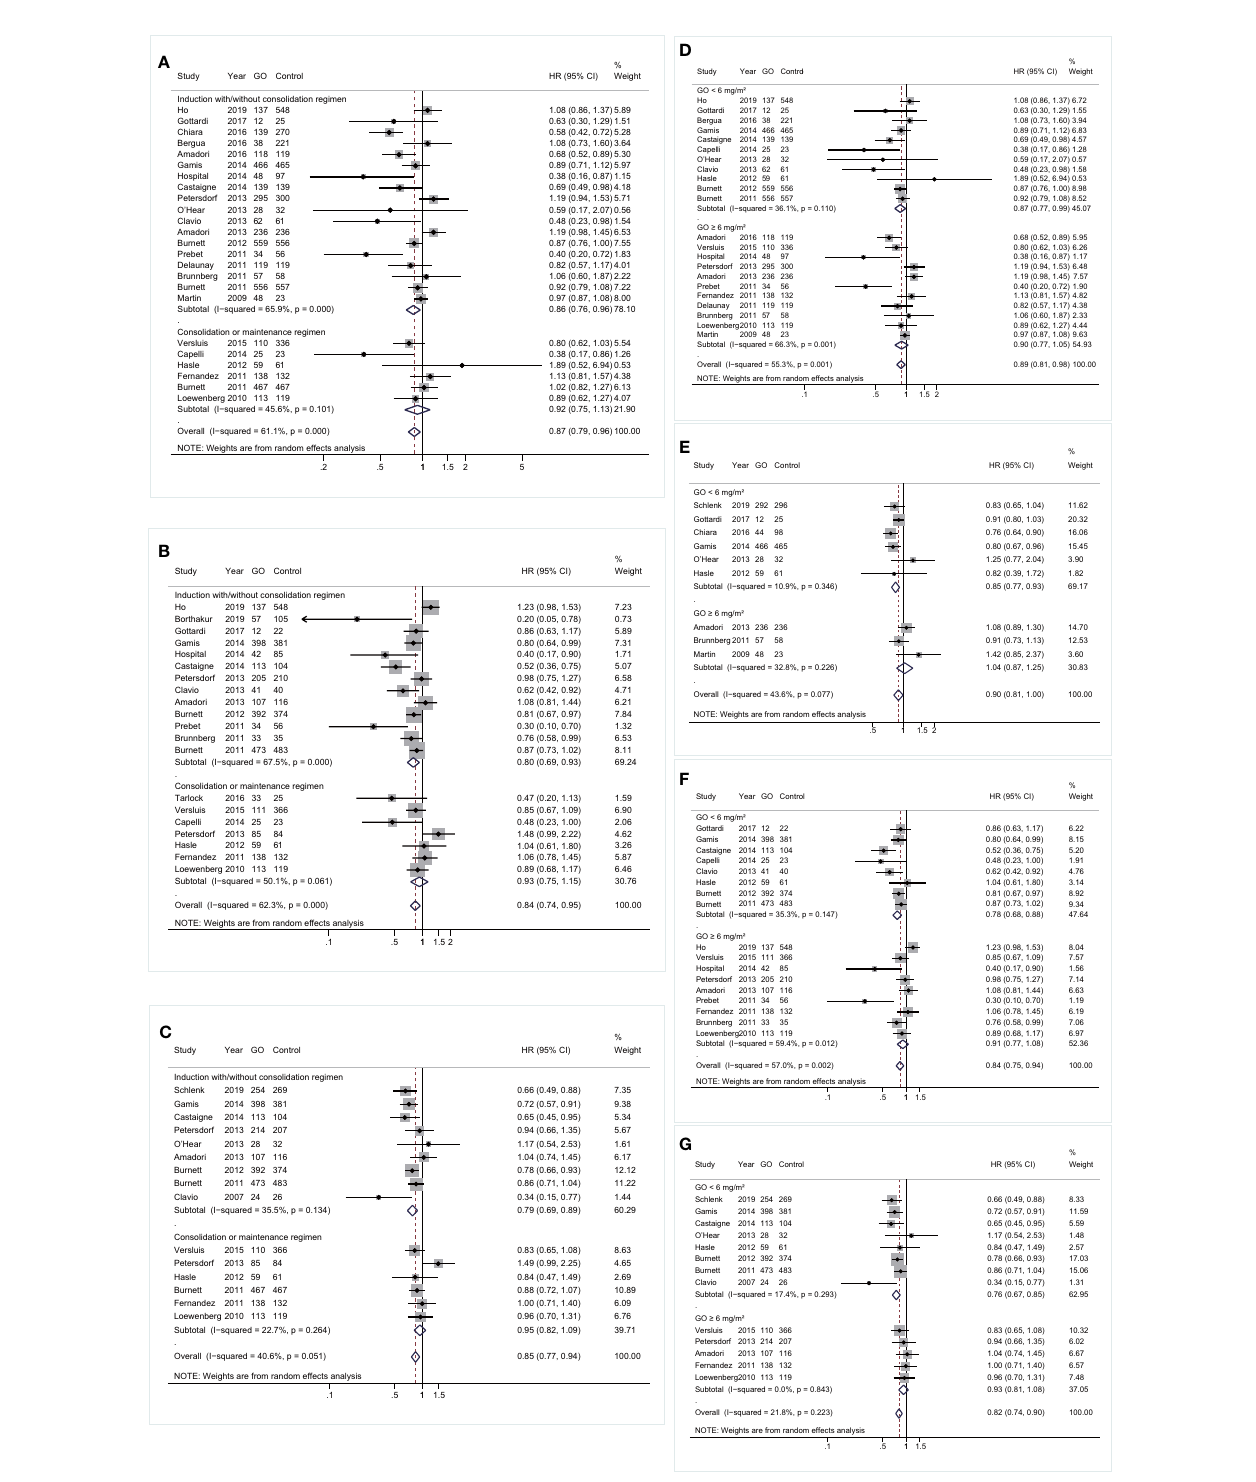
FIGURE 6 | Prognostic subgroup analyses regarding treatment stages and doses of GO. (A) OS subgrouped by treatment stages. (B) RFS subgrouped by treatment stages. (C) CIR subgrouped by treatment stages. (D) OS subgrouped by GO doses. (E) EFS subgrouped by GO doses. (F) RFS subgrouped by GO doses. (G) CIR subgrouped by GO doses. The diamonds represent the overall summary HR estimates with 95% CI. GO, gemtuzumab ozogamicin; OS, overall survival; EFS, event-free survival; RFS, relapse-free survival; CIR, cumulative incidence of relapse; HR, hazard ratio; 95% CI, 95% con fi dence